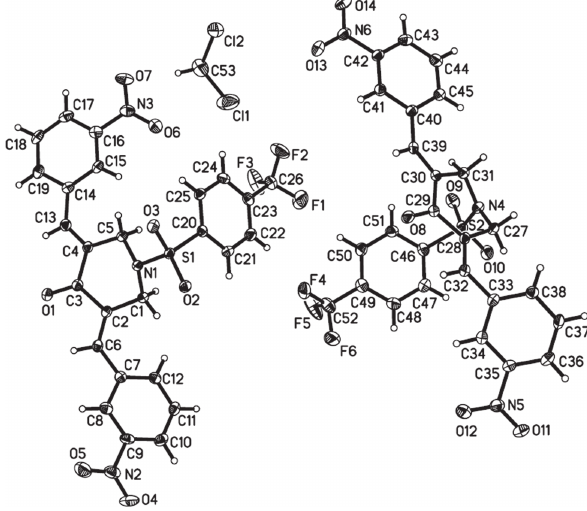
Table 1: Data collection and